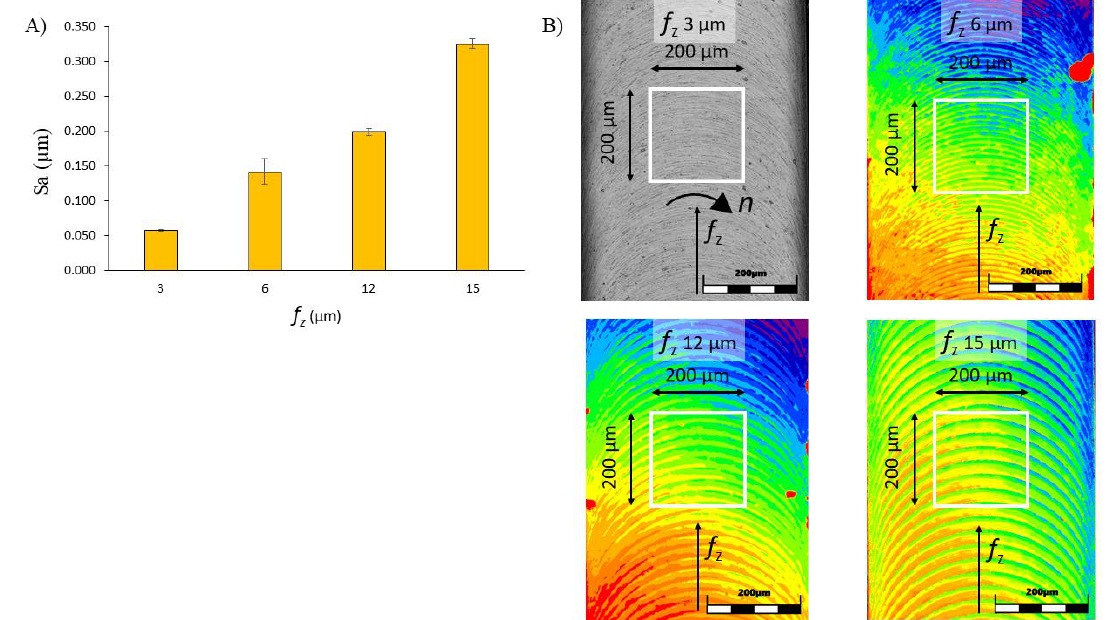
Figure 6: A) Values of surface roughness, Sa, as a function of feed per tooth. B) Machined surfaces